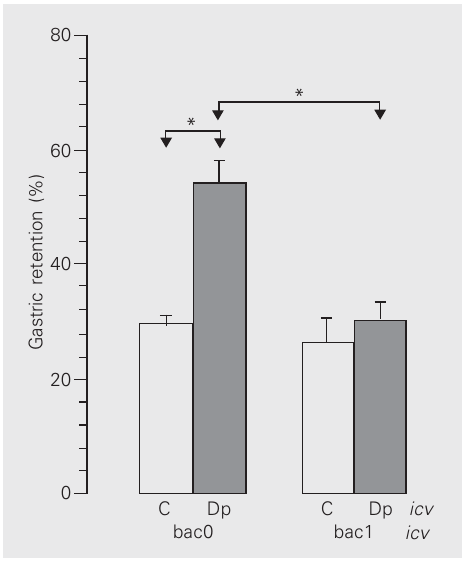
Figure 2. Gastric retention of a saline test meal 10 min after orogastric administration to rats. Eight days before the experi- ment, all animals were im- planted with a stainless steel cannula into the right lateral ven- tricle. The animals were injected icv through an internal cannula with 5 µl vehicle (C) or an equal volume of solution containing 4 µmol (1333.2 µg) dipyrone (Dp), followed by injection of 5 µl ve- hicle (bac0) or an equal volume of solution containing 1 µg baclofen (bac1). Gastric reten- tion, reported as mean ± SEM in % for N = 8 animals, was deter- mined 10 min after removal of the internal cannula. *P < 0.01 (Tukey